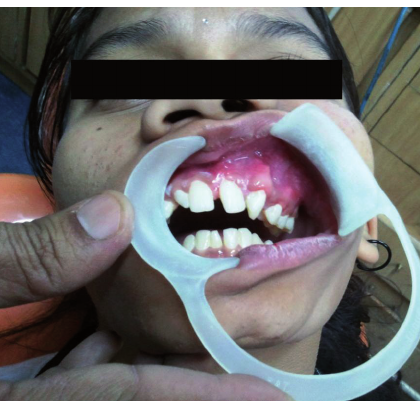
Figure 9: Postoperative image showing intraoral healing.